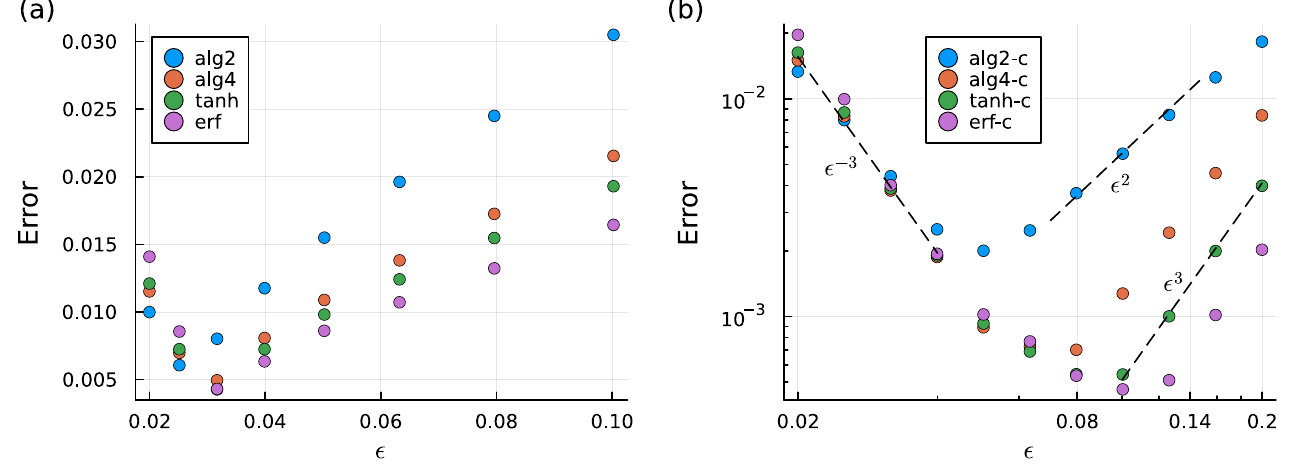
Figure 2. Error (sup-norm) in the computed velocity field on the sphere boundary versus the regularization parameter (cid:101) for the forward problem of a unit sphere translating at unit velocity U in a fluid with unit viscosity. Here, the surface traction is prescribed as the constant vector q = 3 U /2. The error is given as the sup-norm of u ( x ) − U for x in the set of discretization points on the sphere surface. The regularizations listed in the legend are those derived from the radial smoothing factors given by Table 1. Smoothing factors utilized in ( a ) leave the boundary velocity uncorrected whereas in ( b ), corrections according to (25) are included. In ( b ), a log-log scale is used to show the power-law dependence (dashed lines) of the error on (cid:101) in the discretization-error- and regularization-error-dominated